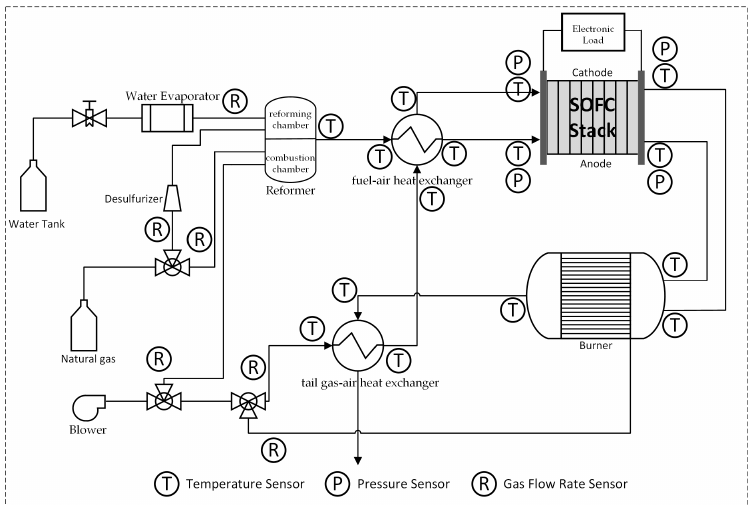
Figure 2. The SOFC system